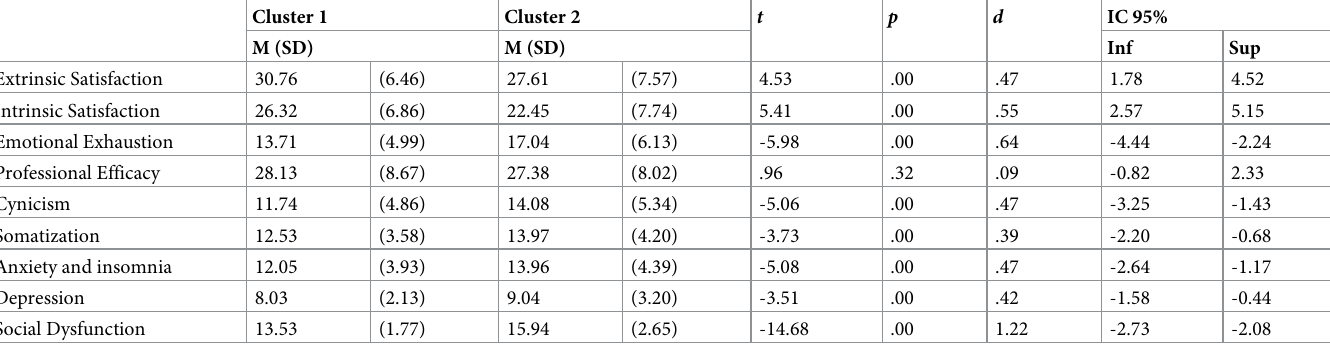
Table 4. Means, SD and ANOVAs of the clustering and profiling variables.